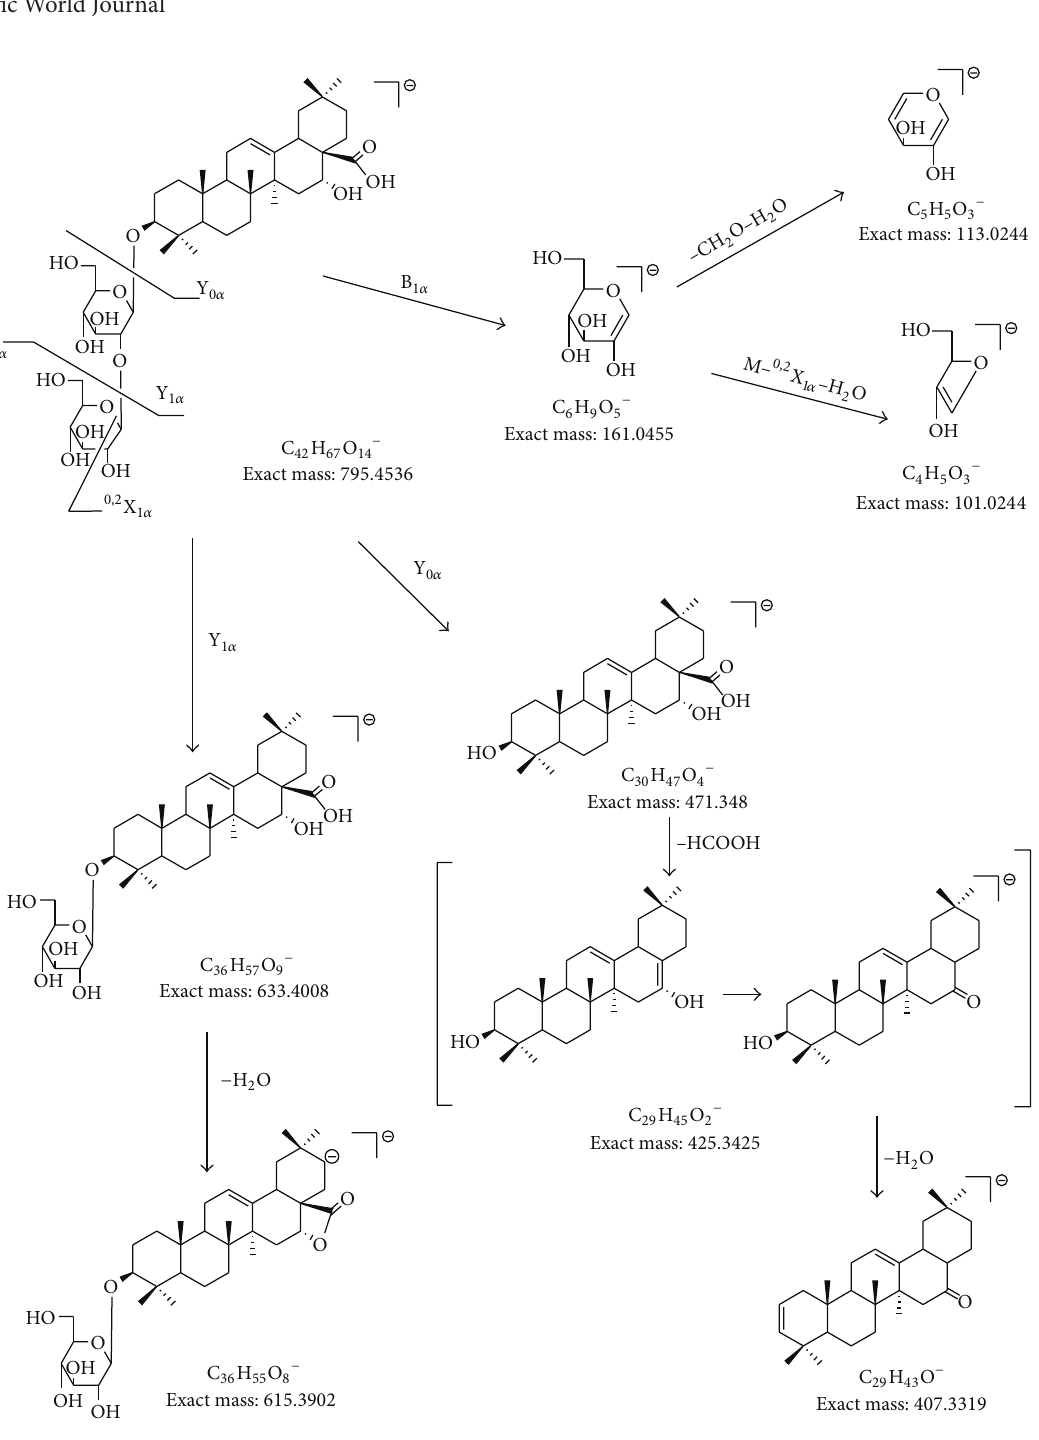
Figure 6: Fragmentation pattern of compound 13